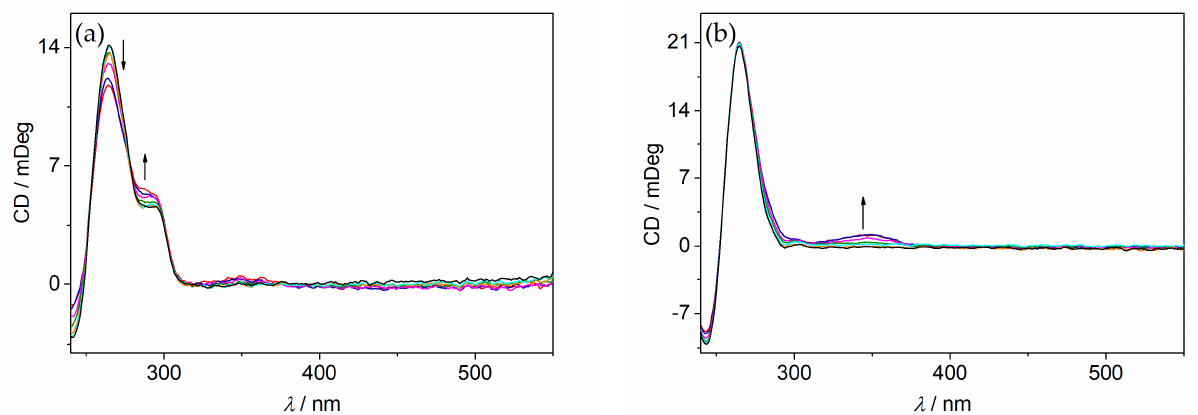
Figure 4. CD spectra of a2 ( a , c DNA = 20 µM) and c-myc ( b , c DNA = 20 µM) in the absence and presence of 2 at LDR = 0 (black), 0.05 (cyan), 0.2 (orange), 0.5 (green), 1.0 (magenta), 1.5 (blue), and 2.0 (red) in a K-phosphate buffer ( c K+ = 110 mM, pH 7.0, with 5% v / v DMSO). The arrows indicate the changes in absorption with increasing LDR .